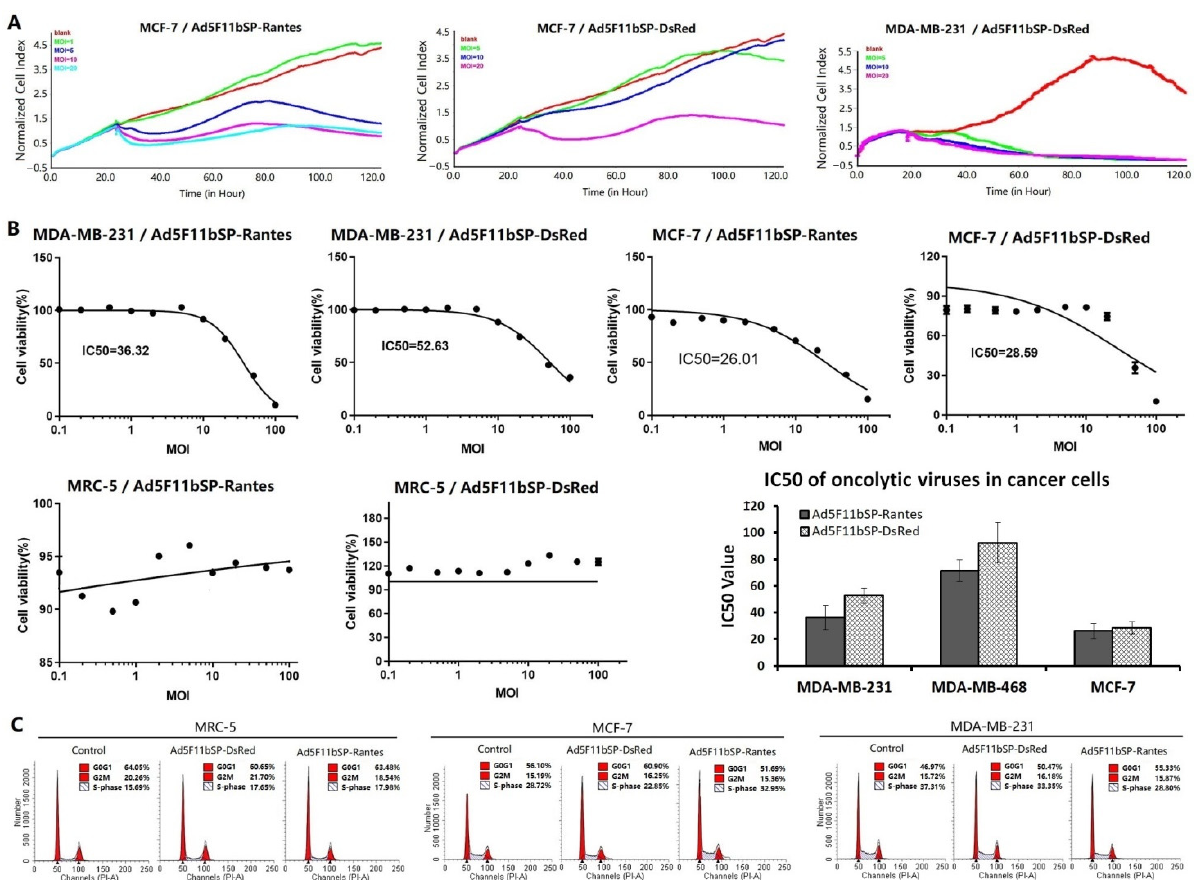
Figure 3. Oncolytic adenovirus Ad5F11bSP-Rantes specifically kills cancer cells. ( A ) Cell lines were cultured in 16-well E-plate at 5 × 10 3 cells/well, and infected with viruses at MOI = 1, 5, 10 and 20 pfu/cell. After virus infection, RTCA was used to track the effect of virus on cell proliferation in real time. ( B ) Cells were cultured in 96-well plates, 1 × 10 4 cells/well, and infected with viruses at MOI = 0, 0.01, 0.02, 0.05, 0.1, 0.2, 0.5, 1.0, 2.0, 5.0, 10.0, 20.0, 50.0 and 100.0 pfu/cell. After 7 days of culture, CCK8 method was used to detect cell viability and IC50 value was calculated. ( C ) Cells were cultured in 96-well plates at 1 × 10 5 cells/well, and infected with viruses at MOI = 5 pfu/cell. Cells were collected after 48 h of culture, and cell cycle was detected by flow cytometry.